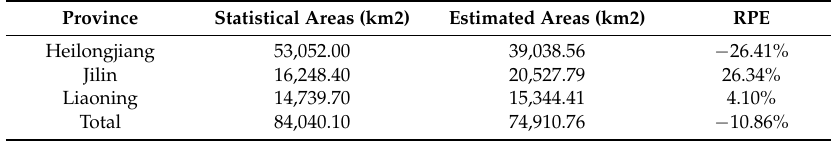
Table 1. Province-level comparison of estimated irrigated areas and statistical areas for